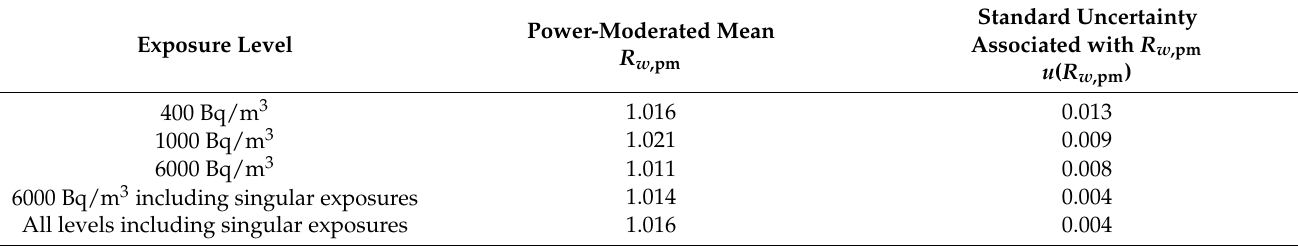
Table 7. Power-moderated mean and its standard uncertainty for the different exposure levels, which were calculated using the Excel spreadsheet